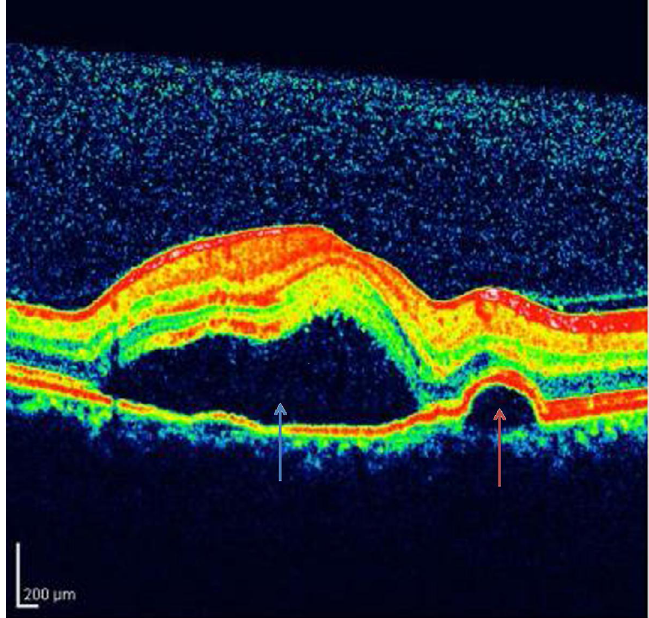
Figure 1: A Spectral OCT image demonstrating (red arrow) the pigment epithelial detachment (PED) and subretinal fluid (blue arrow) in